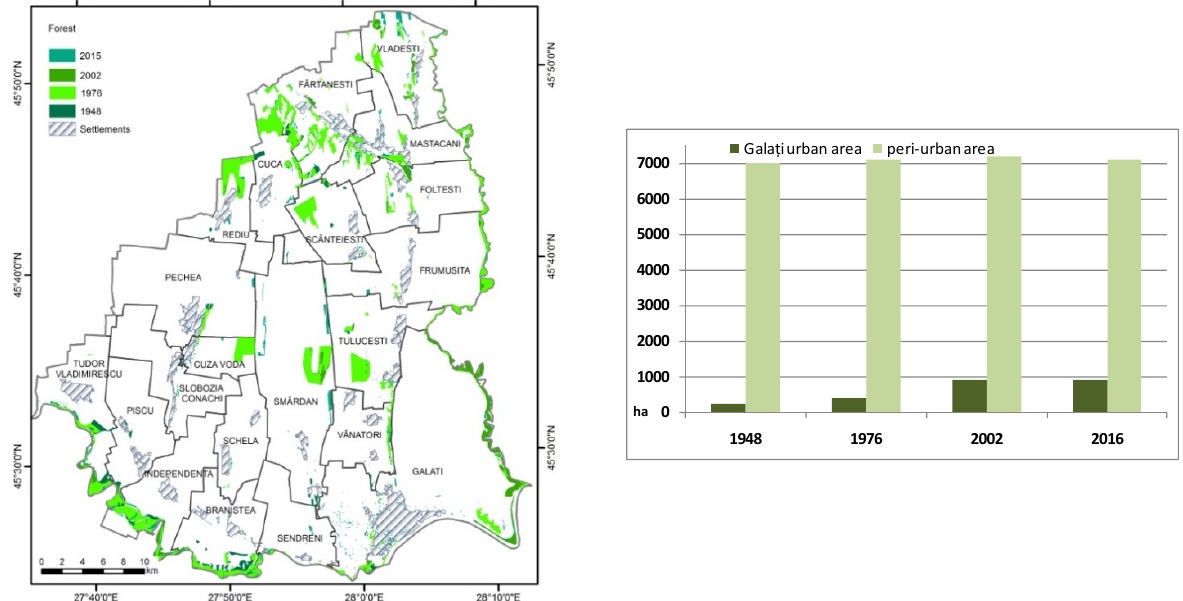
Figure 14. Forest dynamics in the second half of the 20th century through the beginning of the 21st century, Gala ţ i urban and peri-urban area: spatial (left) and statistical (left) considerations.